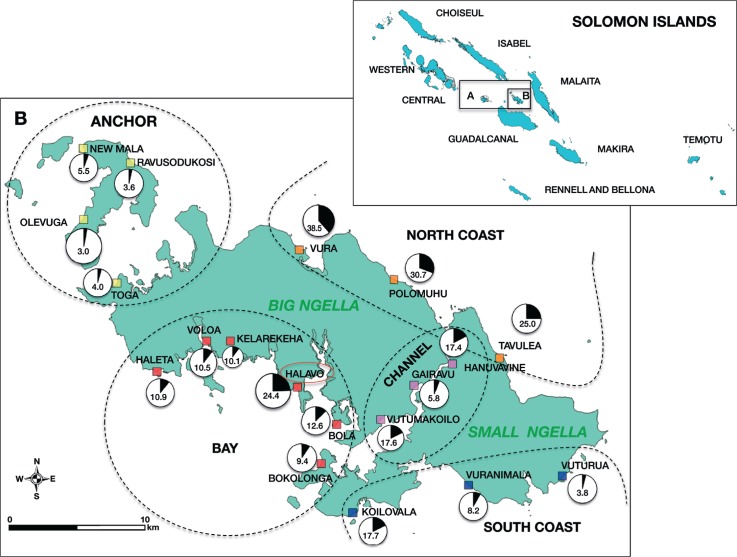
Ngella sampling sites and spatial distribution of P. vivax prevalence (qPCR).The 9 island provinces of SI are shown in the top right inset. A (inset). Central Islands Province. B (inset). Ngella. B. Ngella study catchments and prevalence. Anchor Island (catchments shown in yellow), Bay (catchments in red), Channel (catchments in purple), North Coast (catchments in orange) and South Coast (catchments in blue). The size of the prevalence pie chart reflects village sample size.